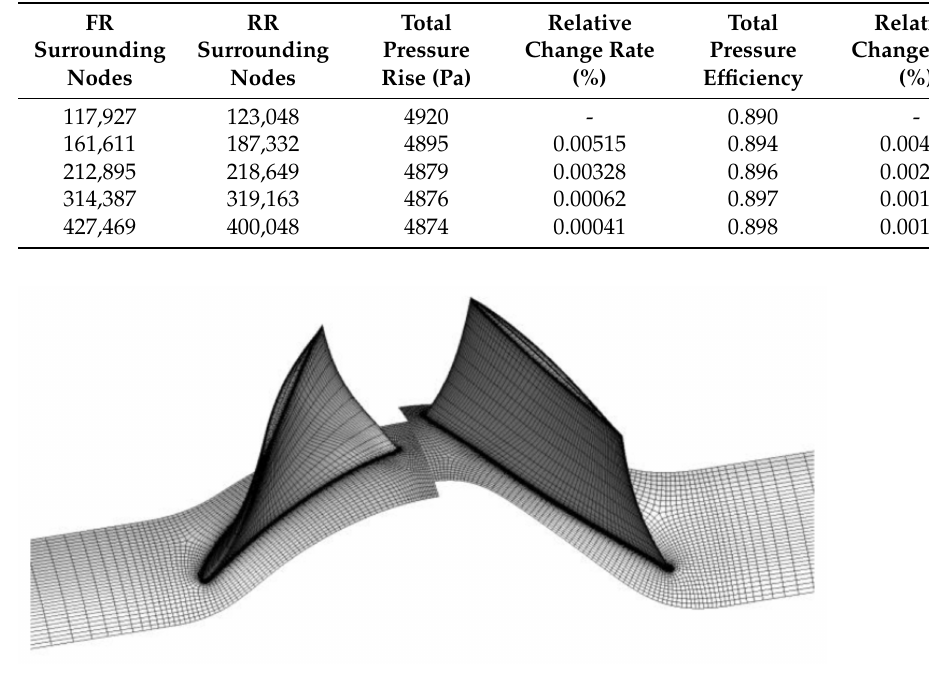
Figure 7. Mesh around the rotors of the baseline CRF